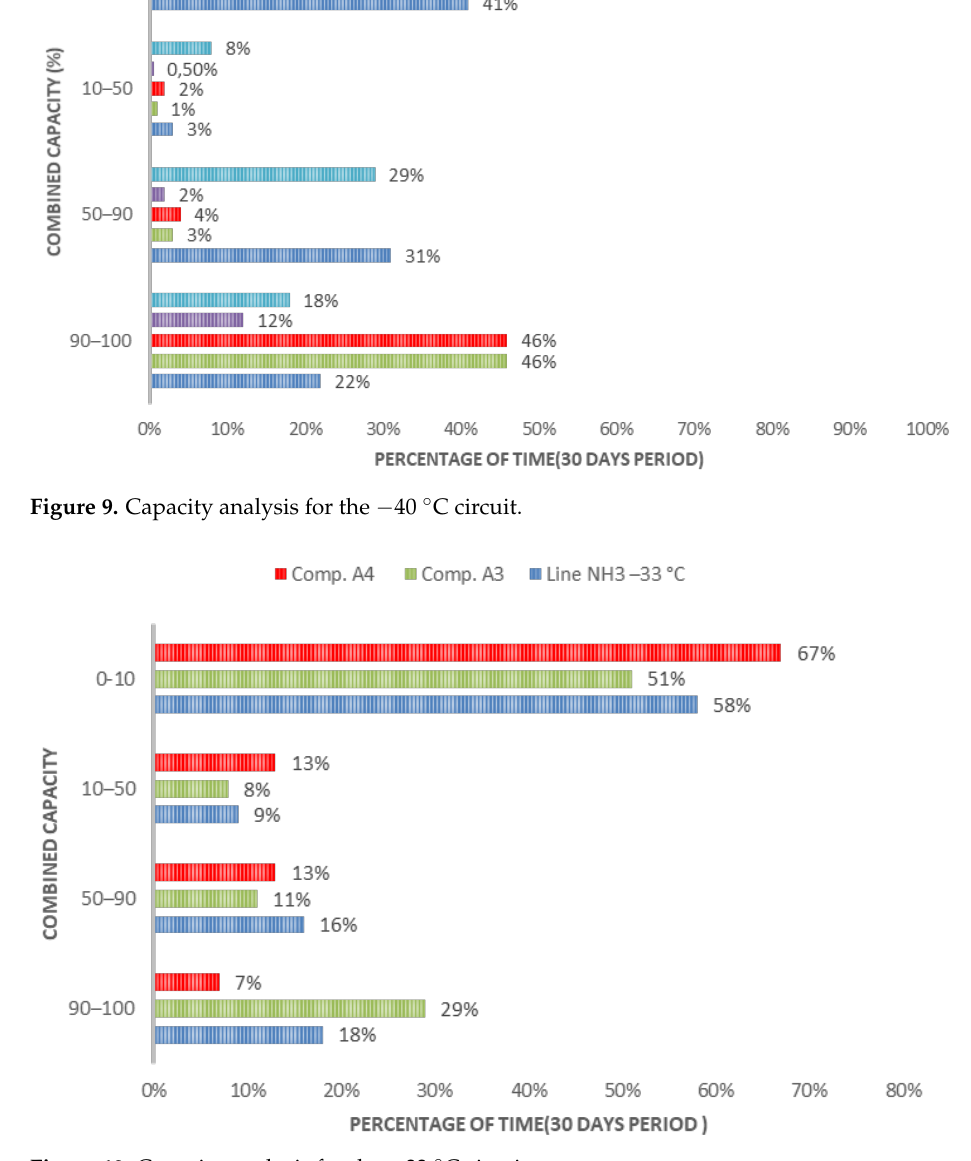
Figure 11. Capacity analysis for the −15 °C circuit. As in the case of the compressor A1 of the −40 °C circuit, the compressor A5 is stopped for more than 85% of the time or operating above 90% (red columns) of the nom- inal speed of the compressor (3000 rpm). Despite this, in the same percentage of time, it is between 50% and 90% the of capacity (brown columns), which indicates that the regula- tion is carried out by the slider practically all the time, with the speed variation operating in a timely manner. This last point indicates that probably, the variable speed drives in both the A1 and A5 cases seem to be programmed mainly for starts, and not to regulate capacity according to energy efficiency criteria.